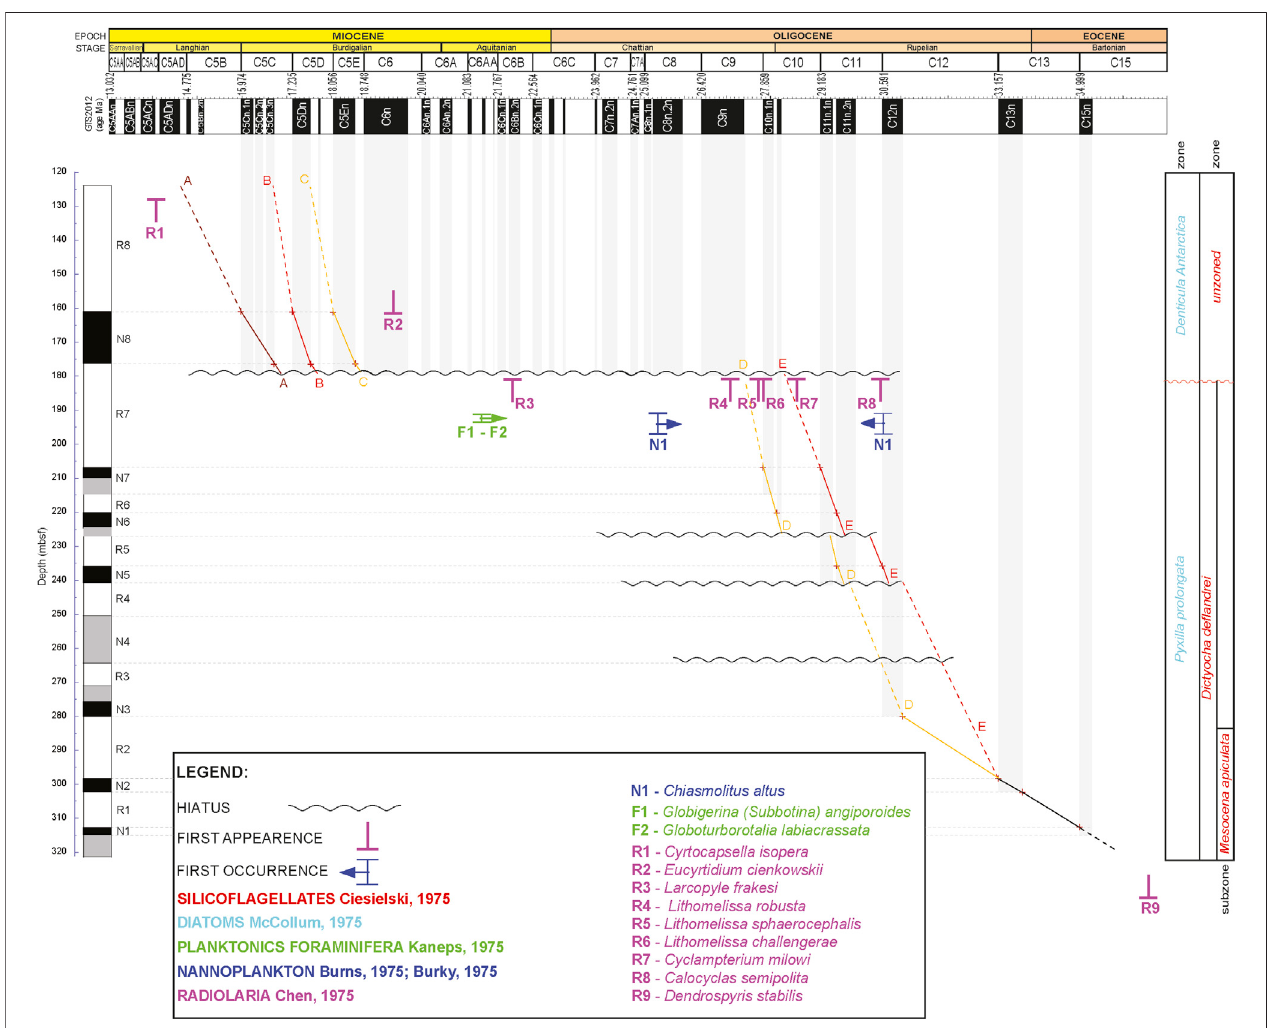
FIGURE 7 | Age vs. depth plot with correlation of DSDP Site 274 polarity zonation to the GPTS of Gradstein et al. (2012). Hiatuses de fi ned from the sedimentologicaldataandbiostratigraphicaldatumarerepresentedfollowingthelegend.MagnetostratigraphicmodelAisindarkred;modelsBandEareinred;models C and D are in